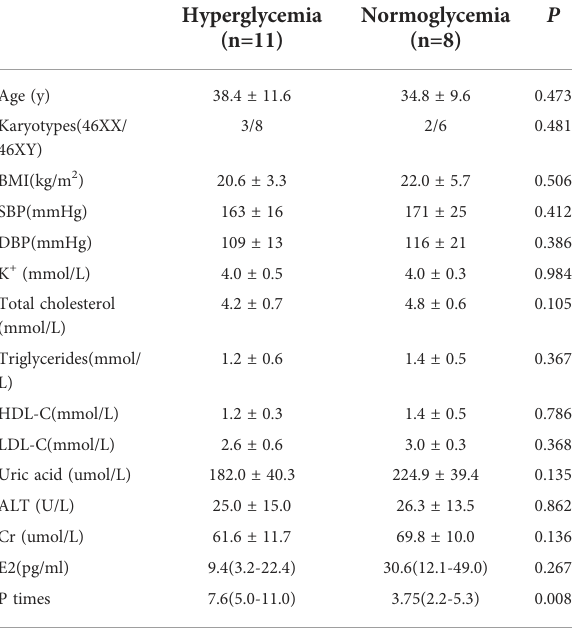
TABLE 3 The clinical characteristics of 19 patients who followed up to 30 years old or above with NGT at baseline by glucose metabolism